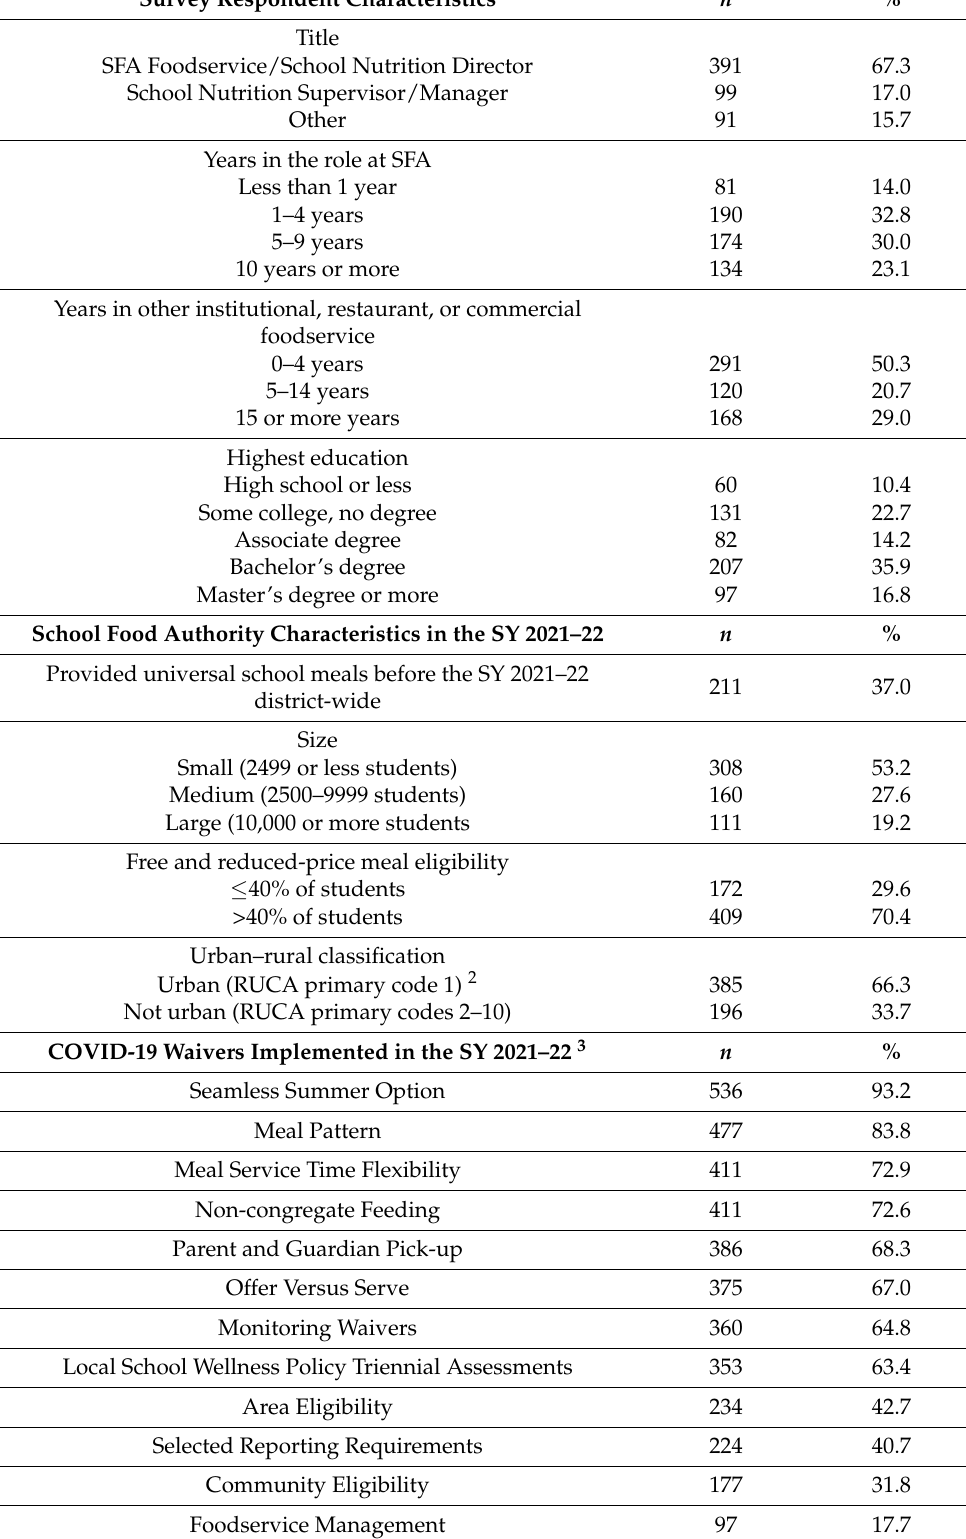
Table 2. Characteristics of survey respondents and their California school food authorities ( n = 581) 1